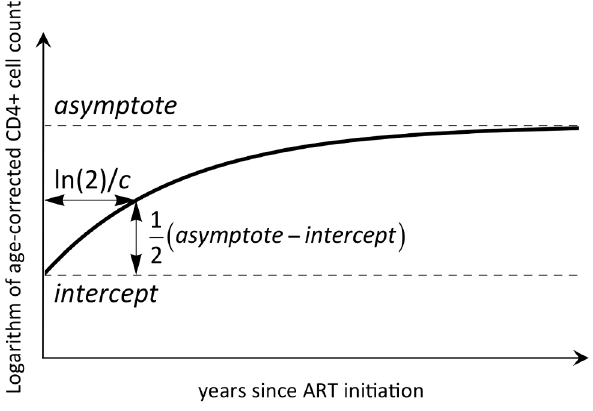
Figure 1. An illustrative representation of the mathematical model used to describe CD4 reconstitution.